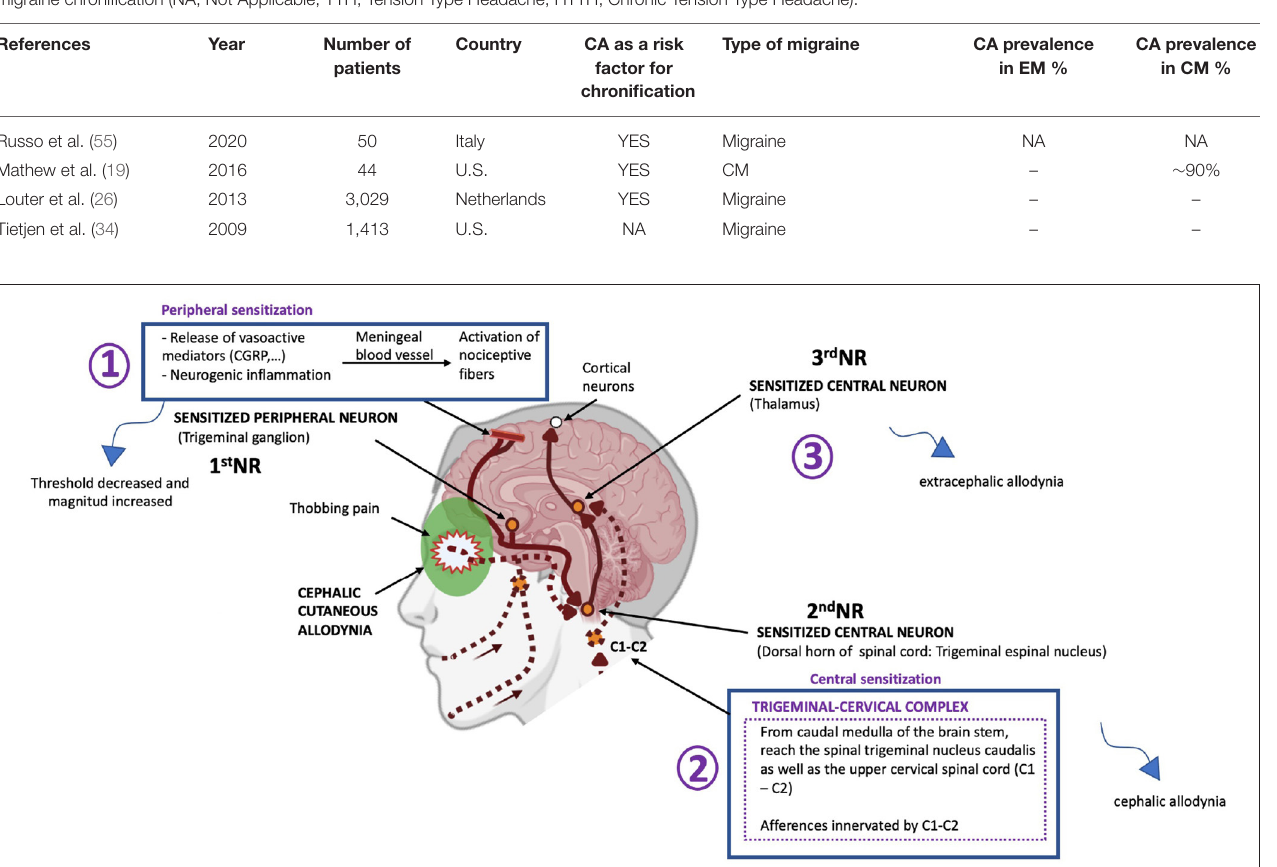
TABLE 2 | Summary of the studies analyzing the prevalence of CA in Episodic Migraine (EM) vs. Chronic Migraine (CM) (in %) and those identifying CA as a risk factor for migraine chronification (NA, Not Applicable; TTH, Tension Type Headache; HTTH, Chronic Tension Type Headache).